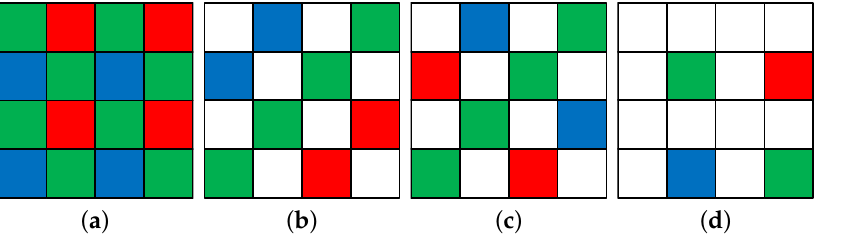
Figure 1. ( a ) Bayer pattern CFA [1], ( b ) Kodak-RGBW CFA [14], ( c ) Sony-RGBW CFA [15], ( d ) Canon- RGBW CFA